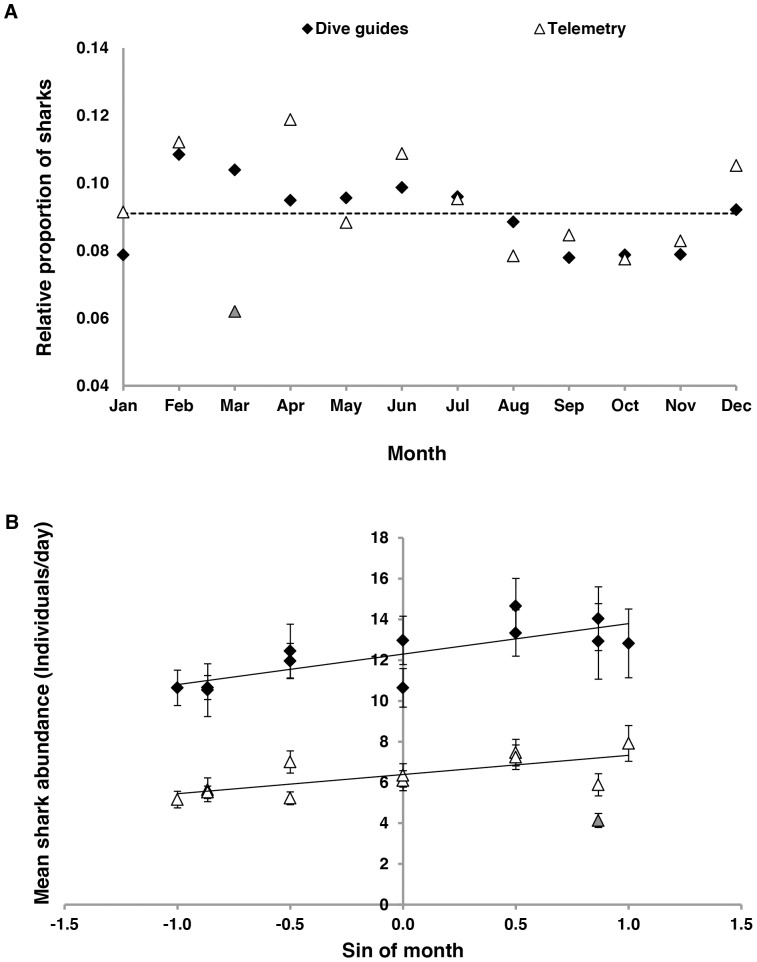
Monthly patterns of abundance of grey reef sharks at monitored sites in Palau.A) Proportion of sharks observed by dive guides and detected by telemetry monthly (calculated as the mean number of sharks observed daily in each month divided by the sum of mean values of all the months). Dashed line indicates the expected values in absence of seasonal variation. B) Mean monthly relative abundance of sharks as function of sine-transformed month. Error bars indicate SE. Dive guides: y = 1.49x+12.23, R2 = 0.60. Telemetry: y = 0.94x+6.39, R2 = 0.51. *Grey triangle indicates detection during low receiver performance and was not included in the analysis (see discussion).